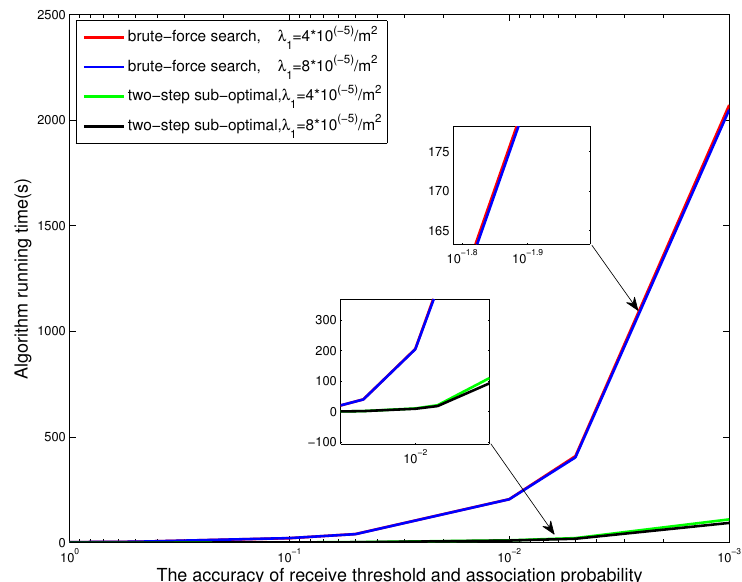
Figure 7. The time cost of brute-force two-dimensional search algorithm and two-step sub-optimal algorithm with respect to the accuracy of system